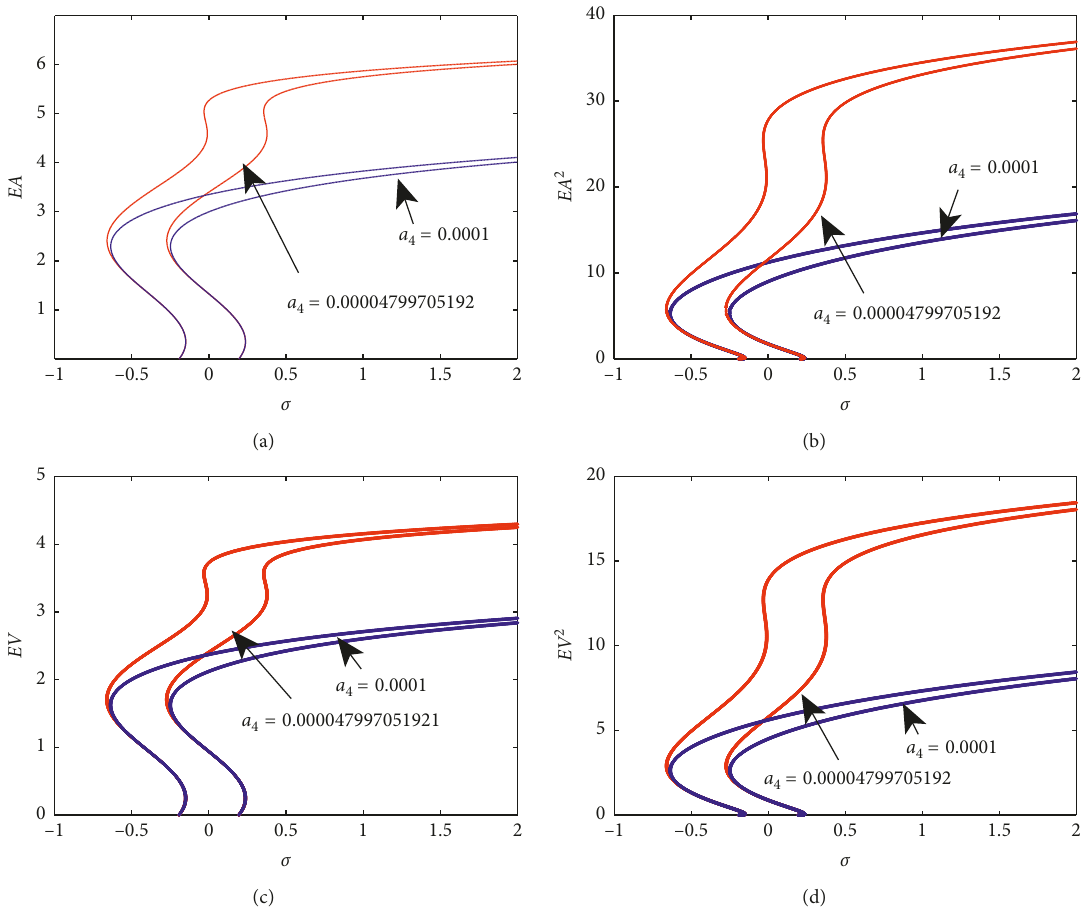
Figure 5: Steady-state moments of displacement and voltage of the multistable energy harvester with different high-order stiffness co- efficients ( c � 0 . 1). (a, b) First-order and second-order steady-state moments of the displacement amplitude; (c, d) first-order and second- order steady-state moments of the voltage